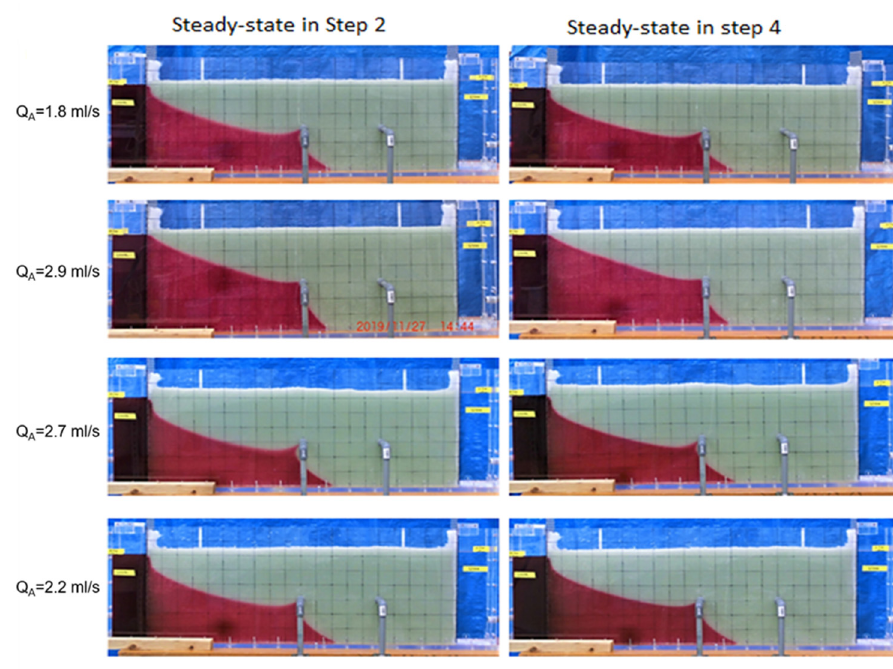
Figure 8. Comparison of steady states at the end of Steps 2 and 4.